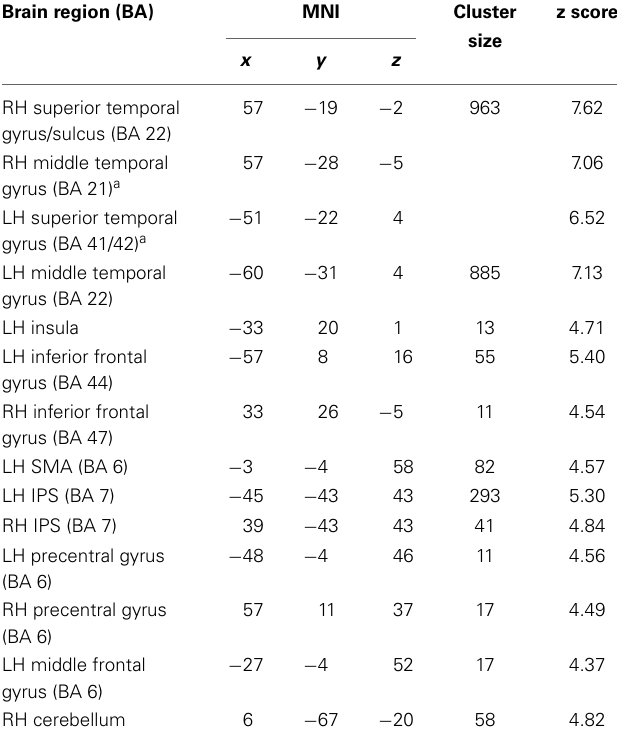
Table 2 | Maxima of the conjunction analysis over both conditions (segmental and suprasegmental) as well as both groups (above